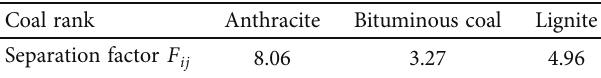
Figure 6: E ff ect of pressure on CO di ff erent rank coal samples. Table 3: Separation factors of di ff erent coal ranks according to the Langmuir